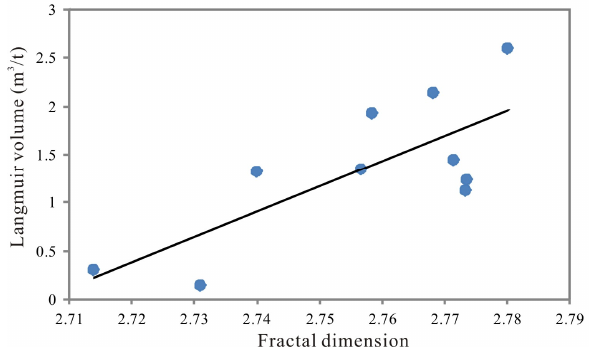
Figure 14 . Relationship between fractal dimension and Langmuir volume.